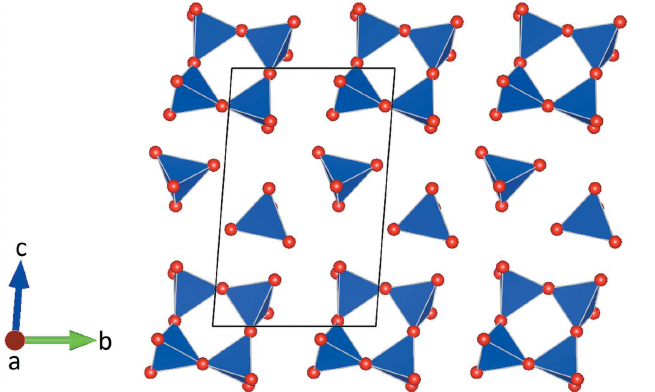
Figure 2 Layer-like arrangement of insular [SiO 4 ] tetrahedra and [Si 4 O 12 ] vierer single rings in a projection along [100].